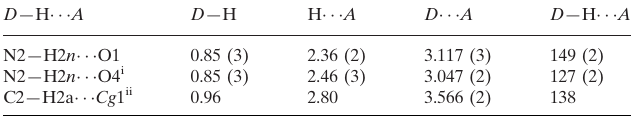
Hydrogen-bond geometry (A˚ , (cid:2)